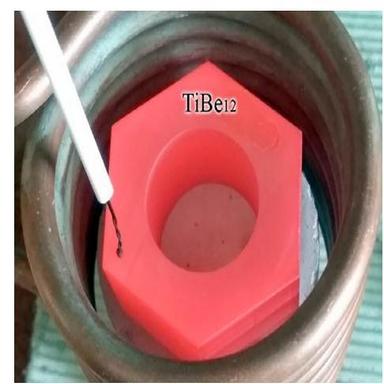
Induction heating of a TiBe12 hexagonal mock-up up to 1100°C as preparation step for advanced thermocycling.